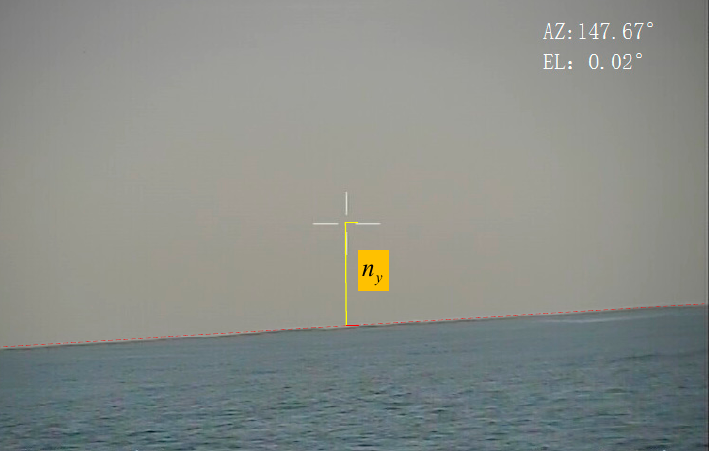
Figure 7. The error in the pitching direction between the LOS and the sea–sky line. The images collected by the electro-optical device during the circumferential scanning process are shown in Figure 8. Figure 8a illustrates that at an azimuth angle of 70.28°, the center of LOS intersects with the sea–sky line and subsequently moves upwards from the sea to the sky. When the azimuth angle is 160.04° (Figure 8b), the LOS reaches the peak value of 1.076° and gradually moves downward from the sky toward the sea. At 249.94°, the LOS intersects with the sea–sky line again and then continues to move downward on the sea surface. When the azimuth angle is 339.76°, the LOS reaches the valley value of − 0.9722°, and after passing the valley point, it moves from the sea to the sky in the opposite direction. The azimuth difference between the peak point and the valley point is about 180°, and that between LOS and sea–sky line intersection is about 180°. This phenomenon occurs repeatedly throughout the scanning procedure, in line with the simulation outcomes presented in Section 3.